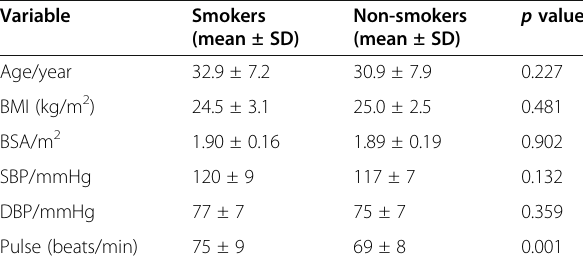
Table 1 Demographic data and clinical characteristics of the 2